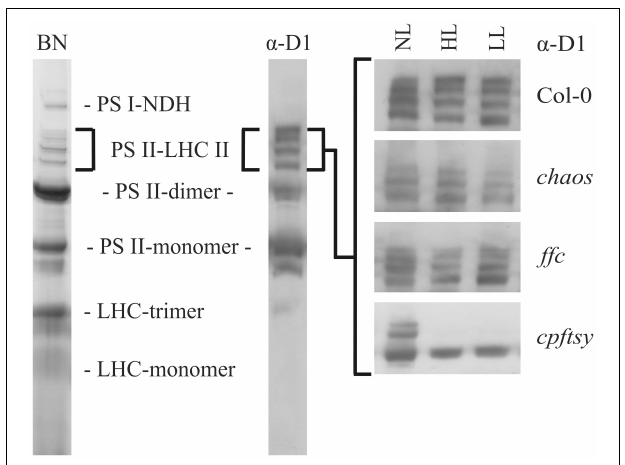
FIGURE 4 | Abundance of PS II-LHC II supercomplexes in wild type and cpSRP mutants at various light conditions. Thylakoid membrane protein complexes of wild type and cpSRP mutants were solubilized with 1.5 (w/v) β -D-dodecylmaltoside after growth at normal light (NL, 120 µ mol photons m − 2 s − 1 ), high light (HL, 1000 µ mol photons m − 2 s − 1 for 16 h) and a subsequent regeneration at low light (LL, 50 µ mol photons m − 2 s − 1 for 8h). Of each sample, an equal amount of chlorophyll (1.5 µ g) was separated by BN-PAGE and blotted onto PVDF membrane. The amount of PS II-LHC II super complexes was analyzed using a D1 specific antibody.